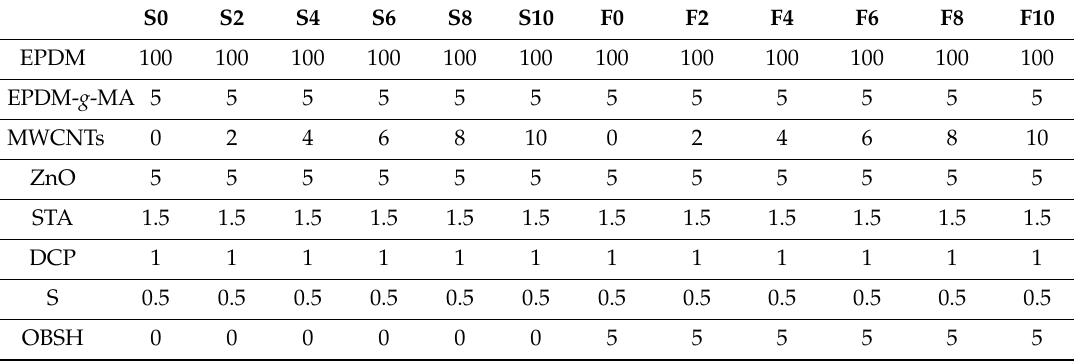
Table 1. Formulation (in phr, parts per hundred of rubber) of the prepared nanocomposite compounds, where S stands for solid and F for